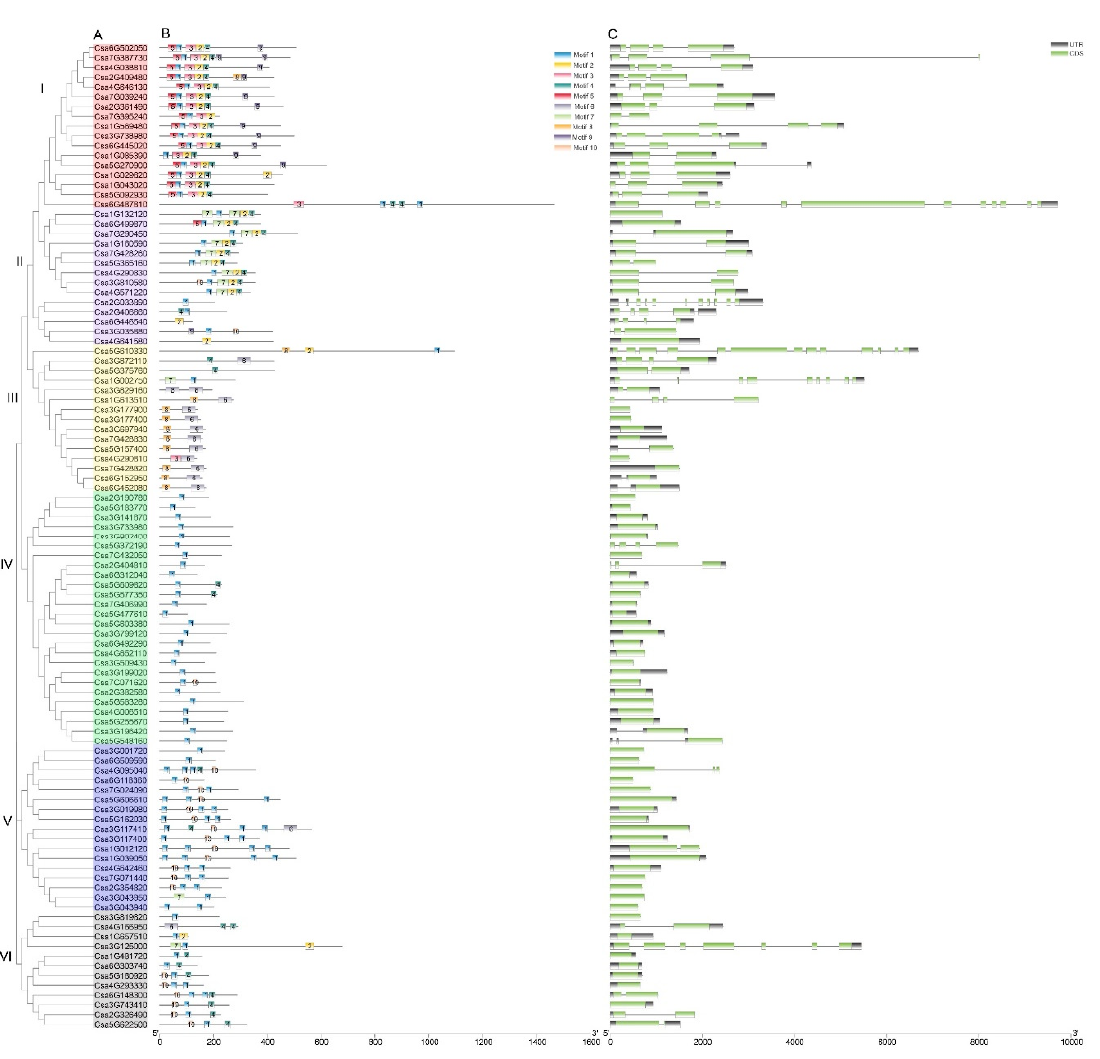
Figure 4. Phylogenetic tree, motif analysis, and gene structure of cucumber C2H2-ZFP genes. ( A ). Phylogenetic analysis of 101 cucumber C2H2-ZFPs was conducted using the MEGA X program. Each of the six C2H2-ZFP groups is indicated in a specific color. ( B ). Conserved motif analysis of C2H2-ZFPs was conducted using MEME tools. Conserved motifs are shown in different colored boxes. ( C ). Gene structure analysis of C2H2-ZFP genes. Coding sequences (CDS) and untranslated regions (UTRs) are represented by black and green boxes, respectively. Introns are represented by black lines.